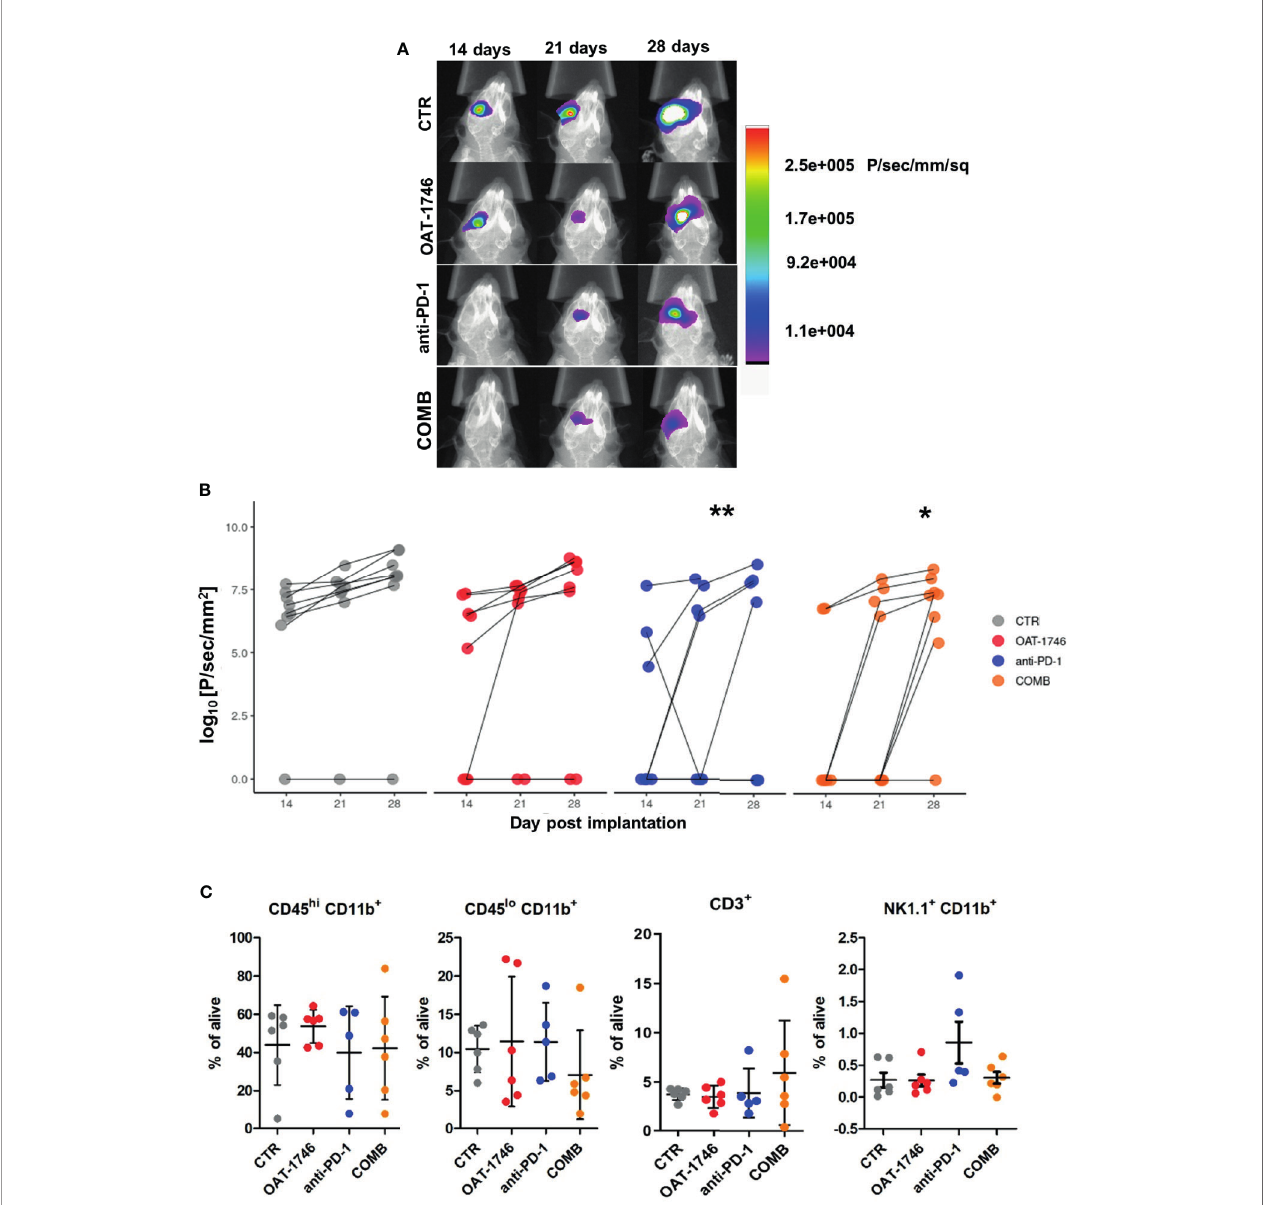
FIGURE 4 | Combined OAT-1746 and anti-PD-1 treatment reduces glioma growth. Mice were implanted with GL261 tdTomato + luc + glioma cells and received saline (CTR), OAT-1746 (twice a day) alone or anti-PD-1 antibody at day 8, 10, 12 and 14 alone or in combination (COMB). (A) Representative images of tumor bioluminescence with Bruker Xtreme imaging. Color intensity represents a relative luciferase signal. Bioluminescence signals are plotted as photon/sec/mm 2 against time at indicated days post-implantation. (B) Tumor size measured using in vivo bioluminescence imaging at various times post-implantation. The effect of treatment and time on tumor progression was assessed with factorial ANOVA; treatment effect F 3,89 = 4.801, p=0.004, day post-implantation effect F 2,89 = 4.726, p=0.011, and Tukey HSD post hoc test: CTRL-OAT p adj =0.455, CTRL-CHECK p adj =0.005, CTRL-COMB p adj =0.021, COMB-OAT-1746 p adj =0.46, COMB-anti-PD-1 p adj =0.96. (C) At day 28 post-implantation animals were perfused with PBS, control and tumor-bearing brains were removed and processed to isolate myeloid cells by FACS. Percentages of peripheral macrophages (CD11b + CD45 hi ), microglia (CD11b + CD45 lo ), CD3 + and NK1.1 + cells were evaluated. Signi fi cance of differences between groups was assessed with One-Way ANOVA followed by Bonferroni ’ s multiple comparison test. p-Values were considered as signi fi cant when **p < 0.01; *p < speci fi c immune cell populations were quanti fi ed. Gating blood-derived macrophages (CD11b + CD45 high ) in strategy is shown in the Supplementary Figure 2 . The experimental gliomas. We noticed an increase in NK cells, administration of OAT-1746 or anti-PD-1 treatment did not however it did not reach statistical signi fi cance in anti-PD-1- change the percentage of microglia (CD11b + CD45 low ) and treated animals compared to control group. An increased